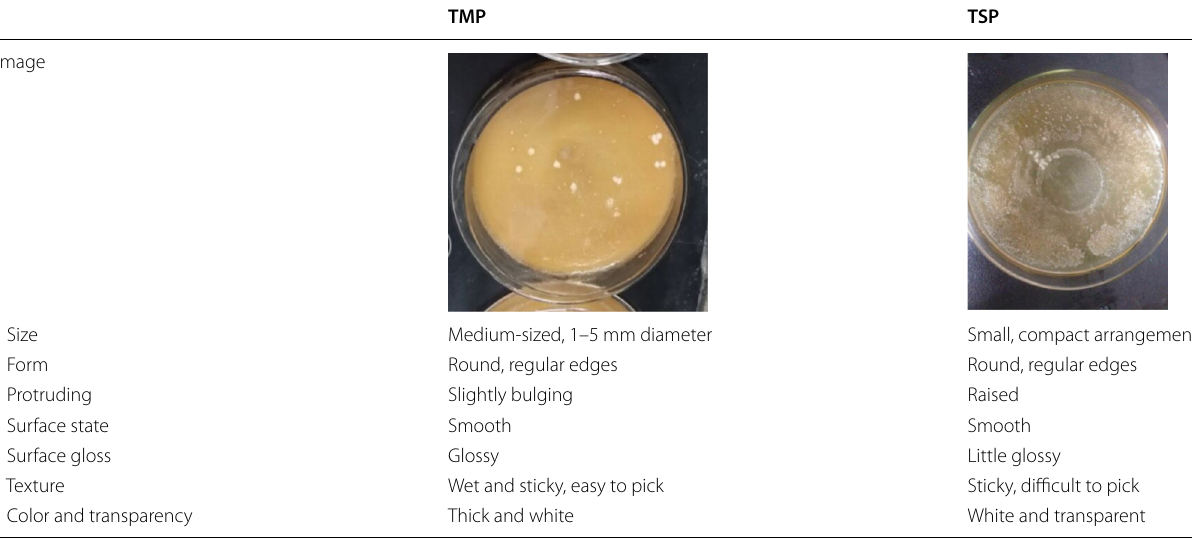
Table 1 Colony morphology comparison of TMP and